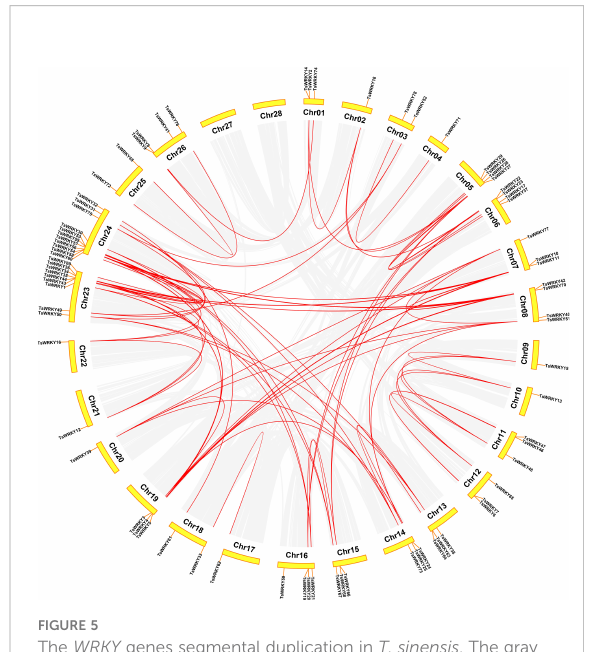
FIGURE 5 The WRKY genes segmental duplication in T. sinensis . The gray lines inside represent synteny blocks, whereas the red lines imply duplicated WRKY gene pairs that have been